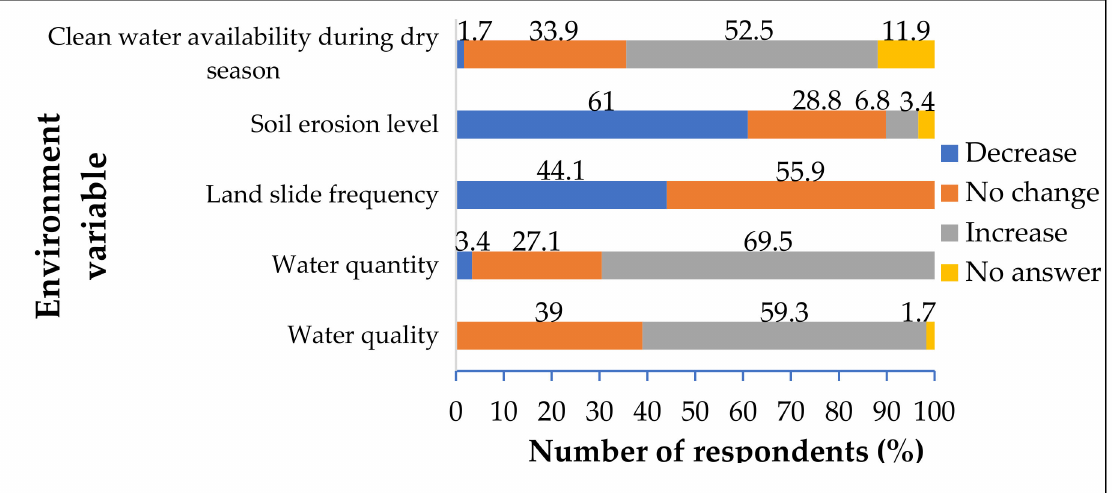
Figure 6. Impact of agroforestry practice on certain environment variables in WAR GFP.